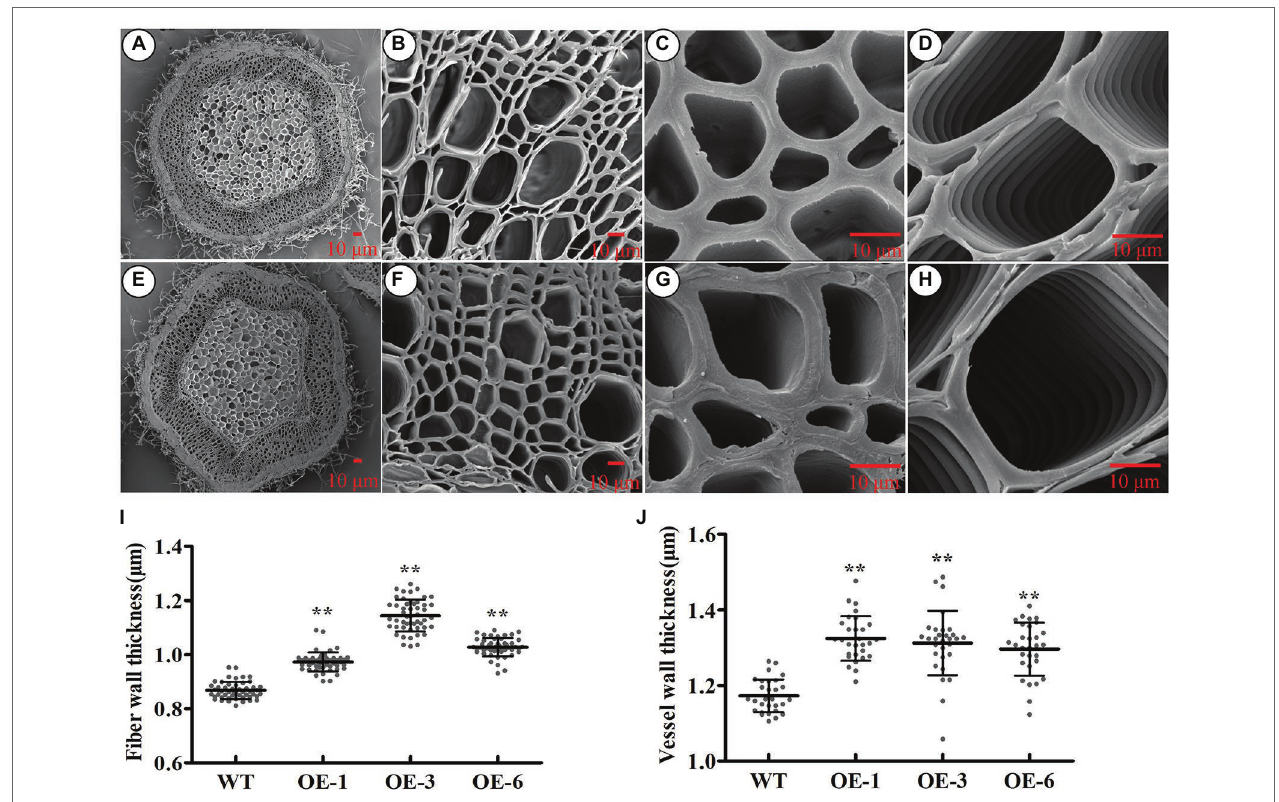
FIGURE 5 | Effect of PtrGATA12 overexpression on the secondary wall thickness of stems in P. trichocarpa . (A–H) The scanning electron microscope of cross stem sections of 90 days old wild-type (A–D) and PtrGATA12 transgenic lines (E–H) . Scale bars = 10 μ m. (C,G) The scanning electron microscope of fiber walls in wild-type and PtrGATA12 transgenic lines. (D,H) The scanning electron microscope of vessel walls in wild-type and PtrGATA12 transgenic lines. (I) The fiber wall thickness of cross stem sections in WT and PtrGATA12 transgenic lines (OE-1, OE-3, and OE-6). (J) The vessel wall thickness of cross stem sections in WT and PtrGATA12 transgenic lines. Error bars represent SD of three biological replicates. Asterisks indicate levels of significance (Dunnett’s test; *, 0.01 < p < 0.05, **, p <